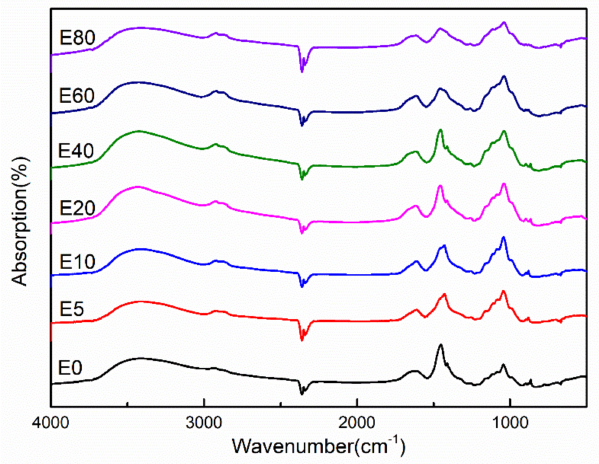
Figure 7. FT-IR spectra of the bank and modified hemicellulose films.